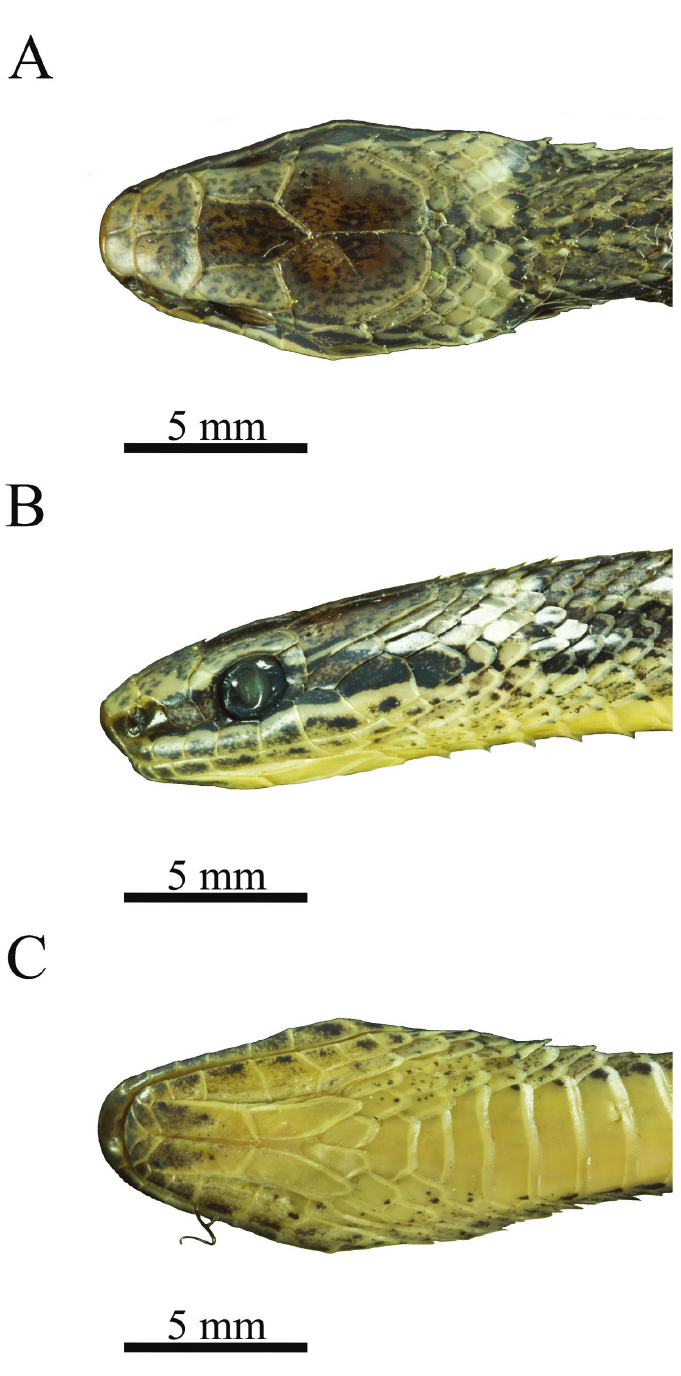
Figure 1. Head of Rhadinaea nuchalis sp. n. Holotype (MZFC-HE 22161) in dorsal ( A ), left lateral ( B ), and ventral ( C )